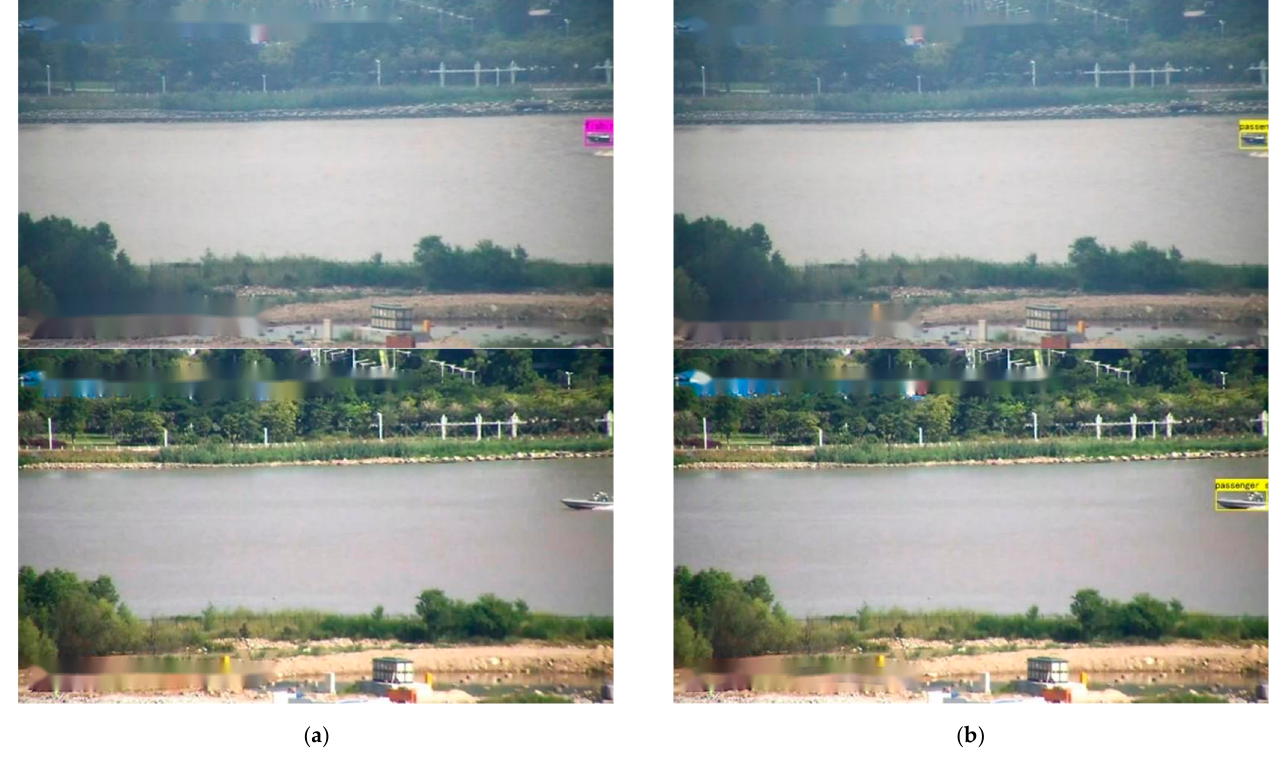
Figure 10. Comparison of small target detection results with occlusion conditions. ( a ) YOLOX_s detection results; ( b ) CBAM-YOLOX detection results.